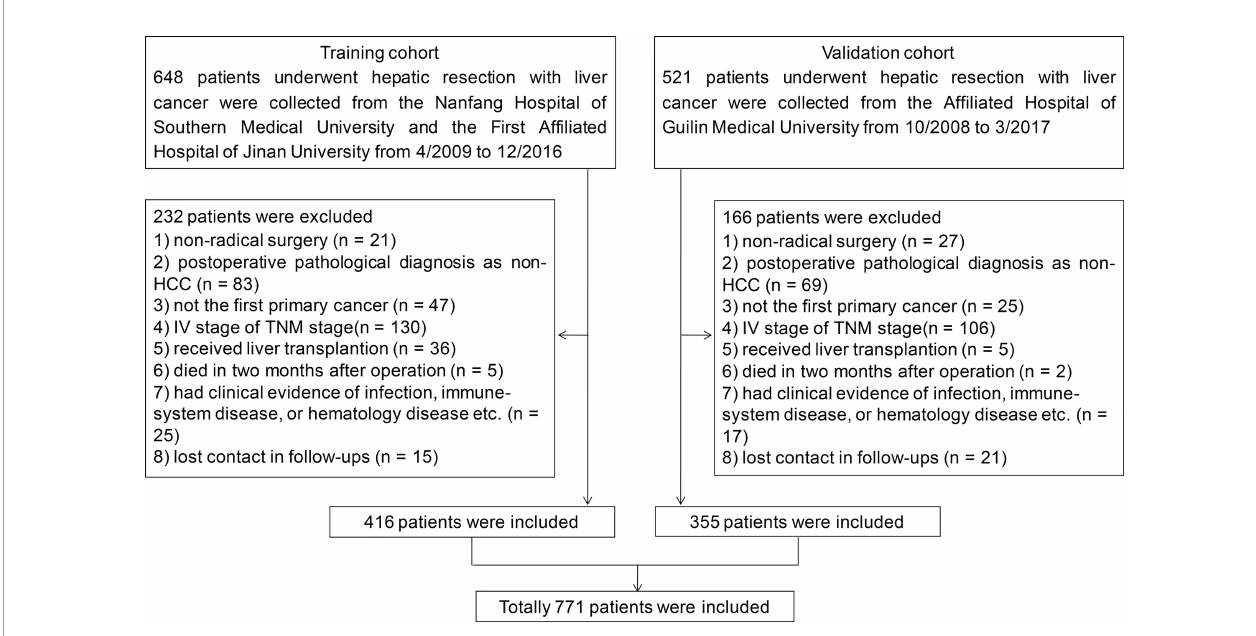
FIGURE 1 | HCC patients ’ enrollment fl owchart.